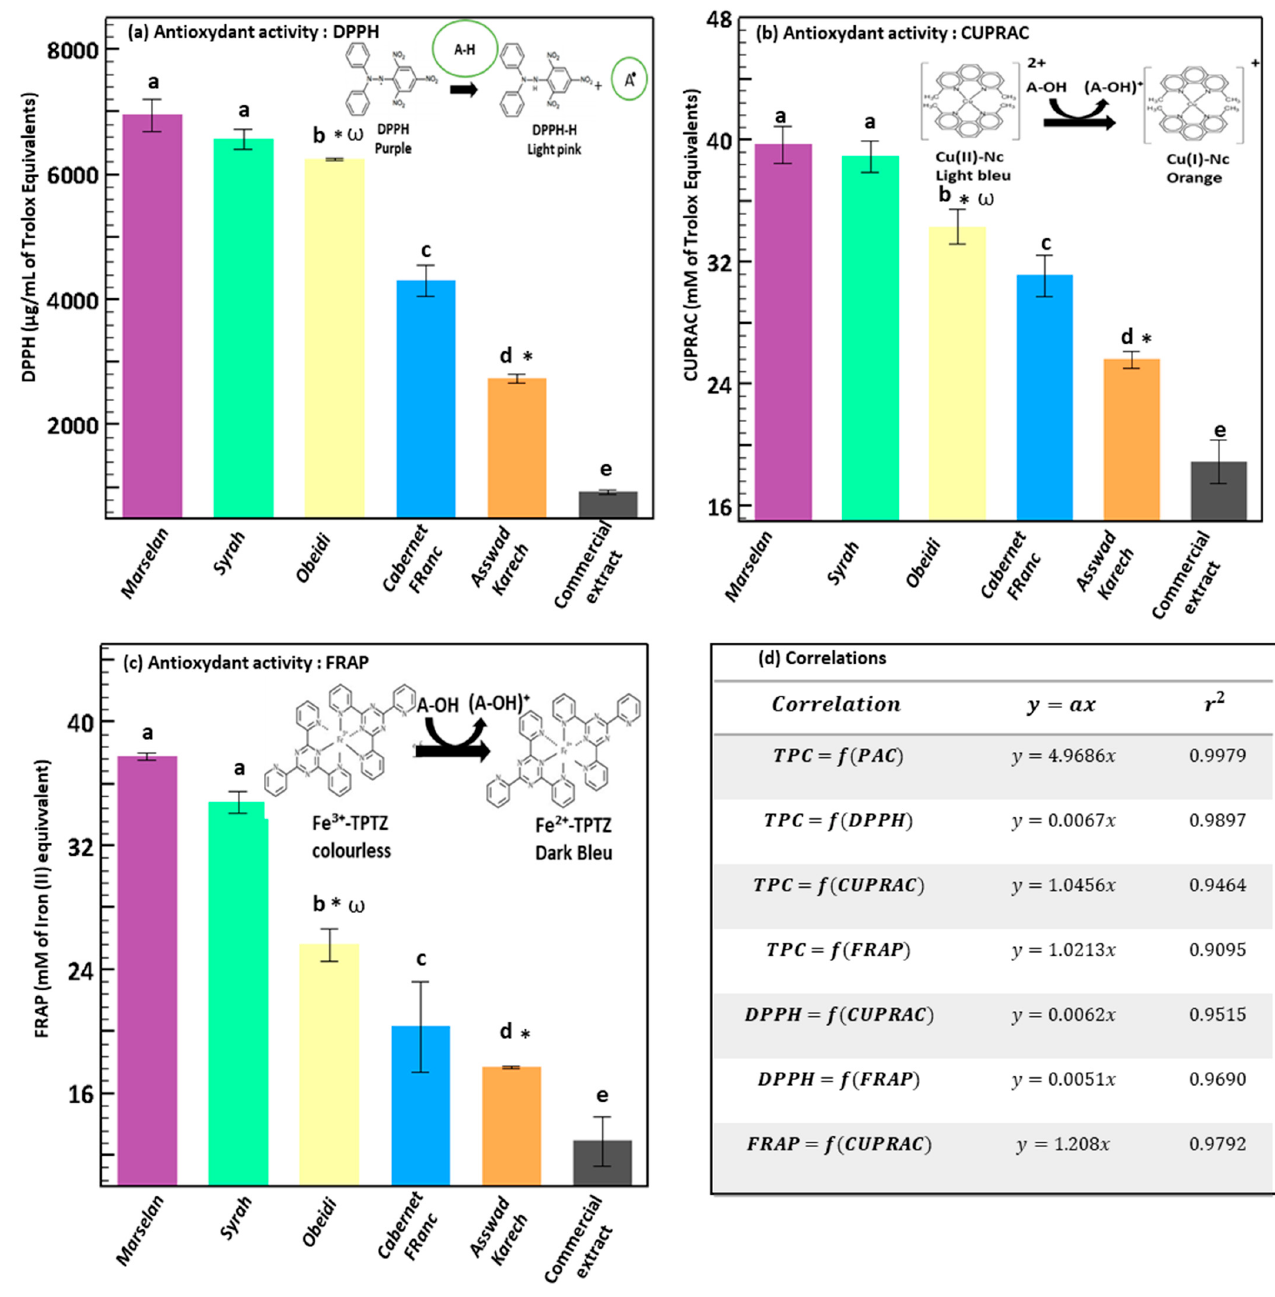
Figure 4. Antioxidant activity of the hydro-glyceric extracts obtained from the grape seeds of Marselan, Syrah, Obeidi, Cabernet Franc, and Asswad Karech, measured by means of DPPH ( a ), CUPRAC ( b ), and FRAP ( c ) colorimetric assays. ( d ) Mean values ± standard deviations were reported. Each letter indicates the same value ( p > 0.05), symbol ω indicates a white variety, and symbol * indicates Lebanese